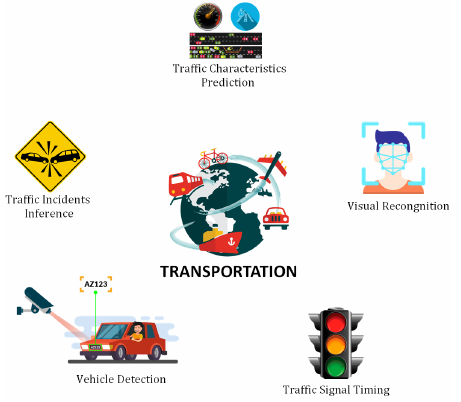
Figure 16. Applications of DL in intelligent transport system. Table 5. State-of-the-art contributions in DL-based intelligent transportation